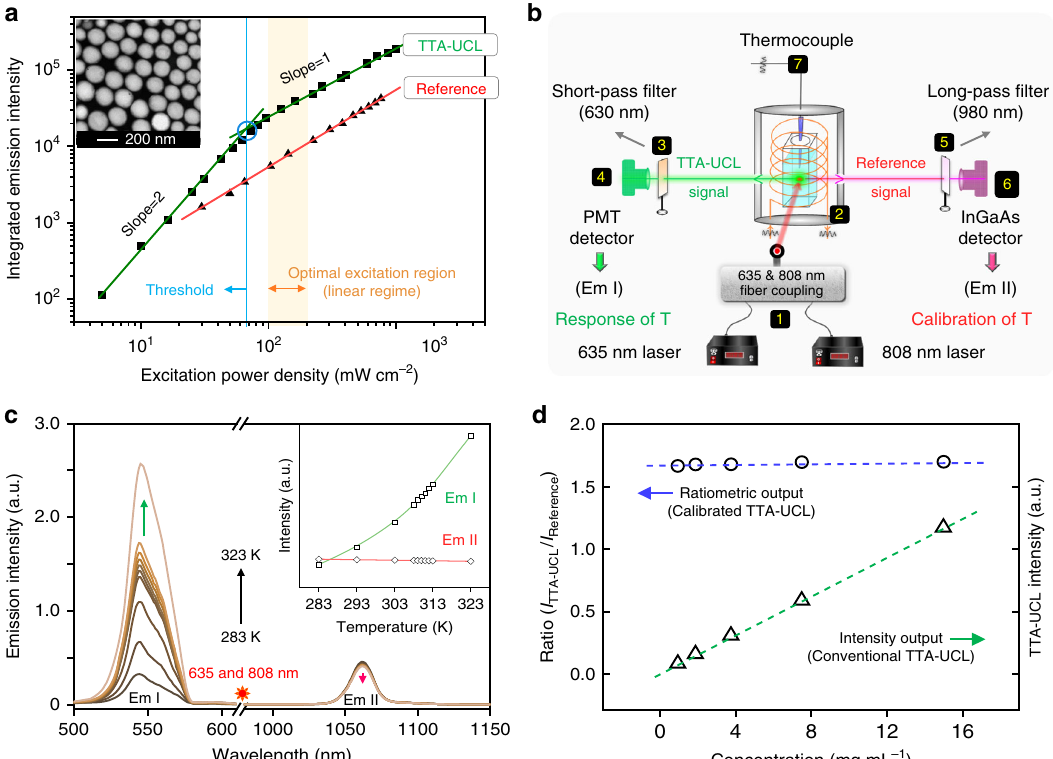
Fig. 3 Properties investigation of TTA-Nd-NPs. a The dual-emissive properties of TTA-Nd-NPs at varying excitation power. TTA-UCL signal peaked at 540 nm and Reference signal peaked at 1060 nm were plotted in the emission pro fi les. Inset: the transmission electron microscope image of TTA-Nd-NPs after negative staining with sodium phosphotungstate. Scale bar is 200 nm. b Schematic illustration of the setup for calibrated TTA-UCL measurement under precisely controlled temperature. c The thermal sensitivity of TTA-Nd-NPs in aqueous solution. The spectra were measured with the excitation of coupled 635 nm (100 mW cm − 2 ) and 808 nm (100 mW cm − 2 ) laser. Inset: the integrated emission intensities of TTA-UCL (Em I, green line) and Reference signals (Em II, red line) as functions of temperature. d The concentration effects on the ratiometric probing method (blue line) and the intensity-based probing method (green line) at room